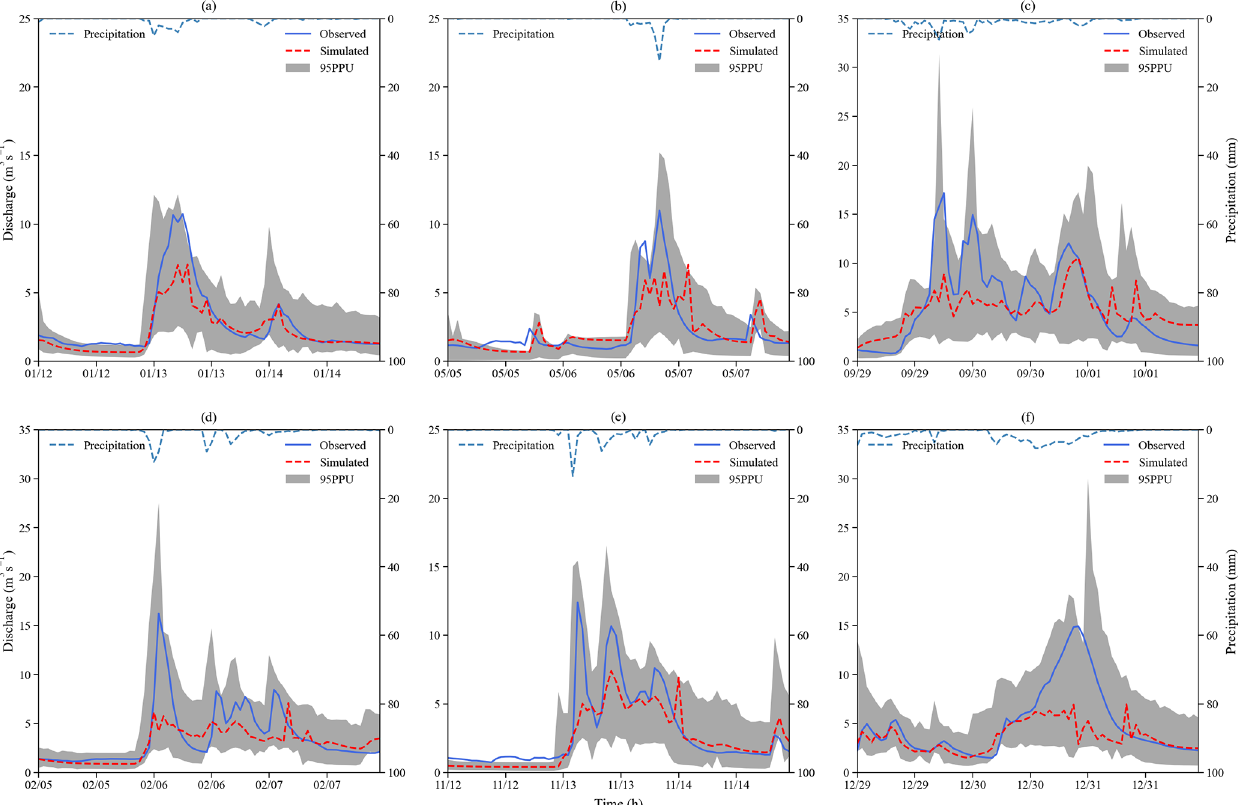
Figure 4. Observed and simulated hourly discharge (m 3 s − 1 ) using the GAML method for the heavy rainfall events that occurred in 2018 and 2019. (a) Event from 12–14 January 2018. (b) Event from 5–7 May 2018. (c) Event from 29 September–1 October 2018. (d) Event from 5–7 February 2019. (e) Event from 12–14 November 2019. (f) Event from 29–31 December 2019. Table 6. Rainfall characteristics of selected events for the years 2018 and 2019. Events Observed Simulated Avg. discharge Peak discharge Time of peak Avg. discharge Peak discharge Time of peak (m 3 s − 1 ) (m 3 s − 1 )